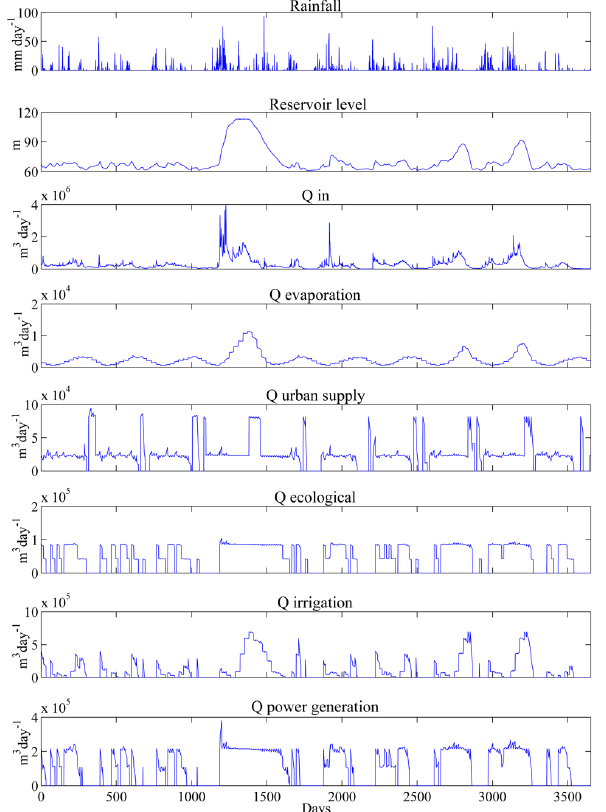
Fig. 4. Simulation results of a 10-yr series.